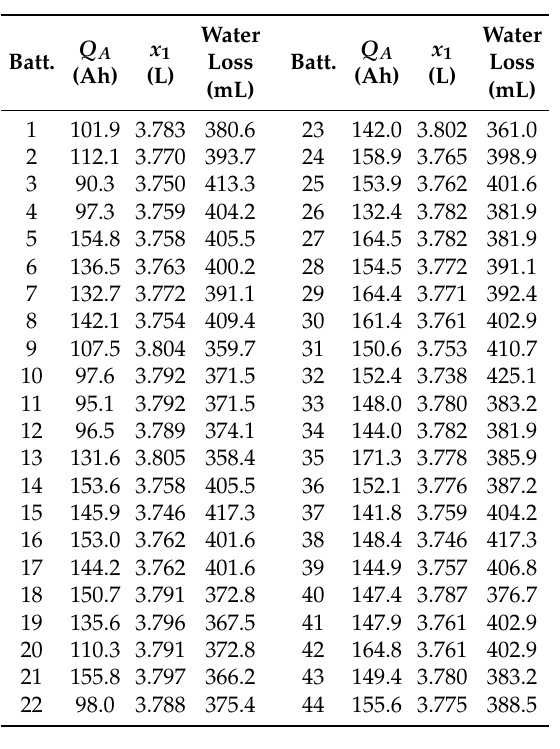
Table A1. Available capacity Q A , level x 1 , and water loss per battery.